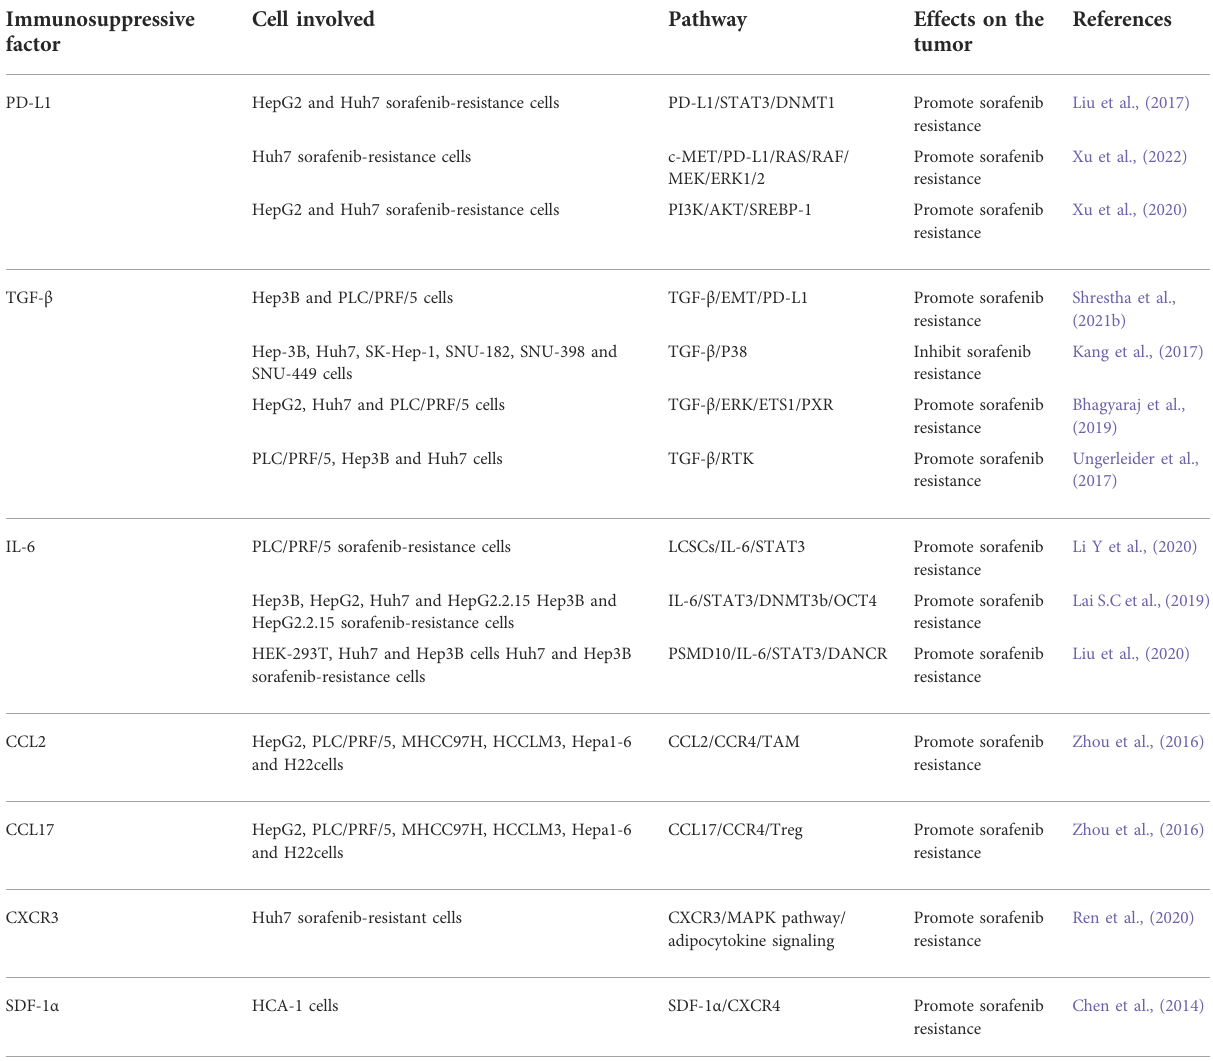
TABLE 1 Immunosuppressive factors and sorafenib resistance in